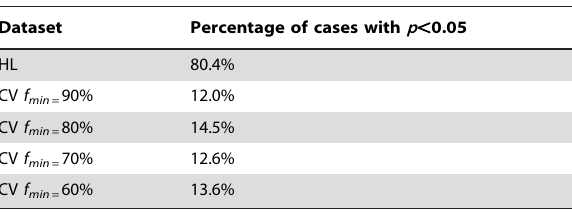
Table 1. Percentage of two-codon U + C families that show significant codon frequency differences between high and low datasets and conserved and variable datasets.